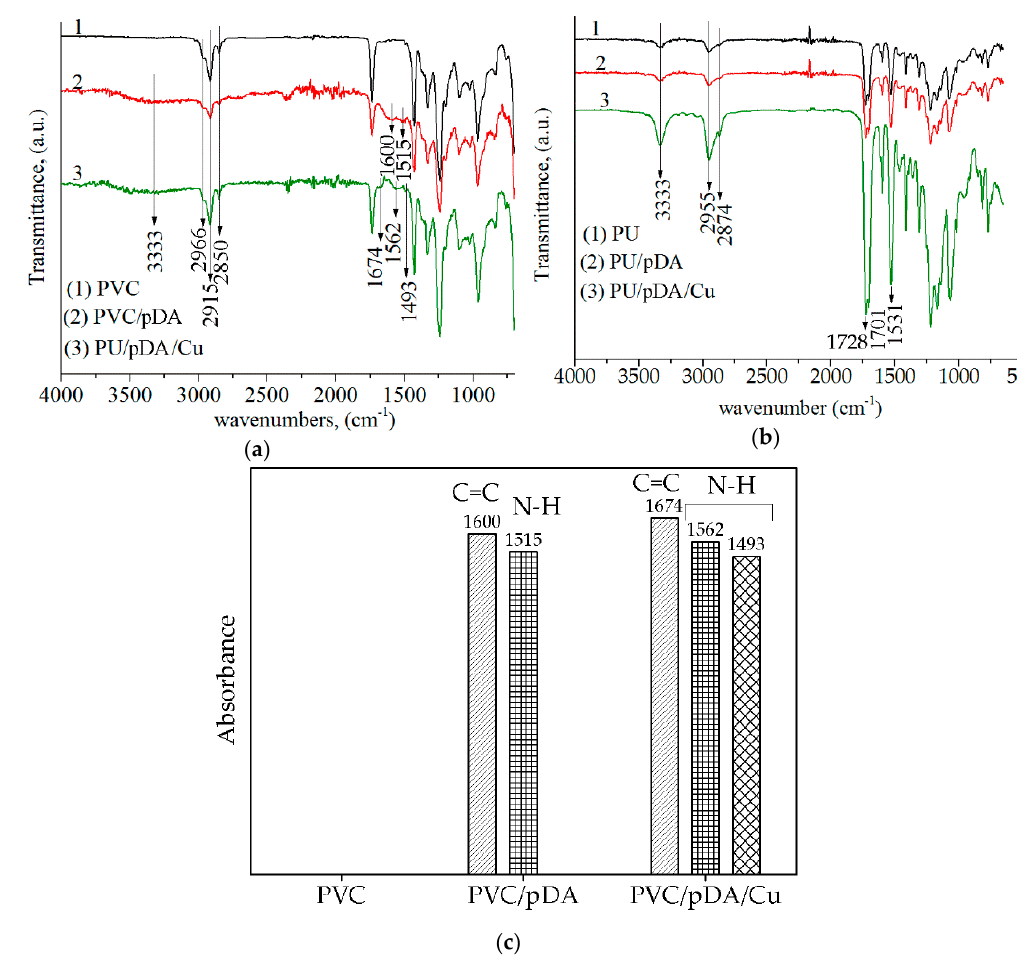
Figure 2. ( a ) Infrared spectra of PVC discs: (1) non-modified; (2) modified with PDA and (3) modified with Cu-PDA; ( b ) Infrared spectra of PU discs: (1) non-modified; (2) modified with PDA and (3) modified with Cu-PDA; ( c ) A diagram of appearing and shifting absorbance bands in Fourier-transform infrared spectroscopy (FTIR) spectra of PVC, PVC/PDA and PVC/PDA/Cu.